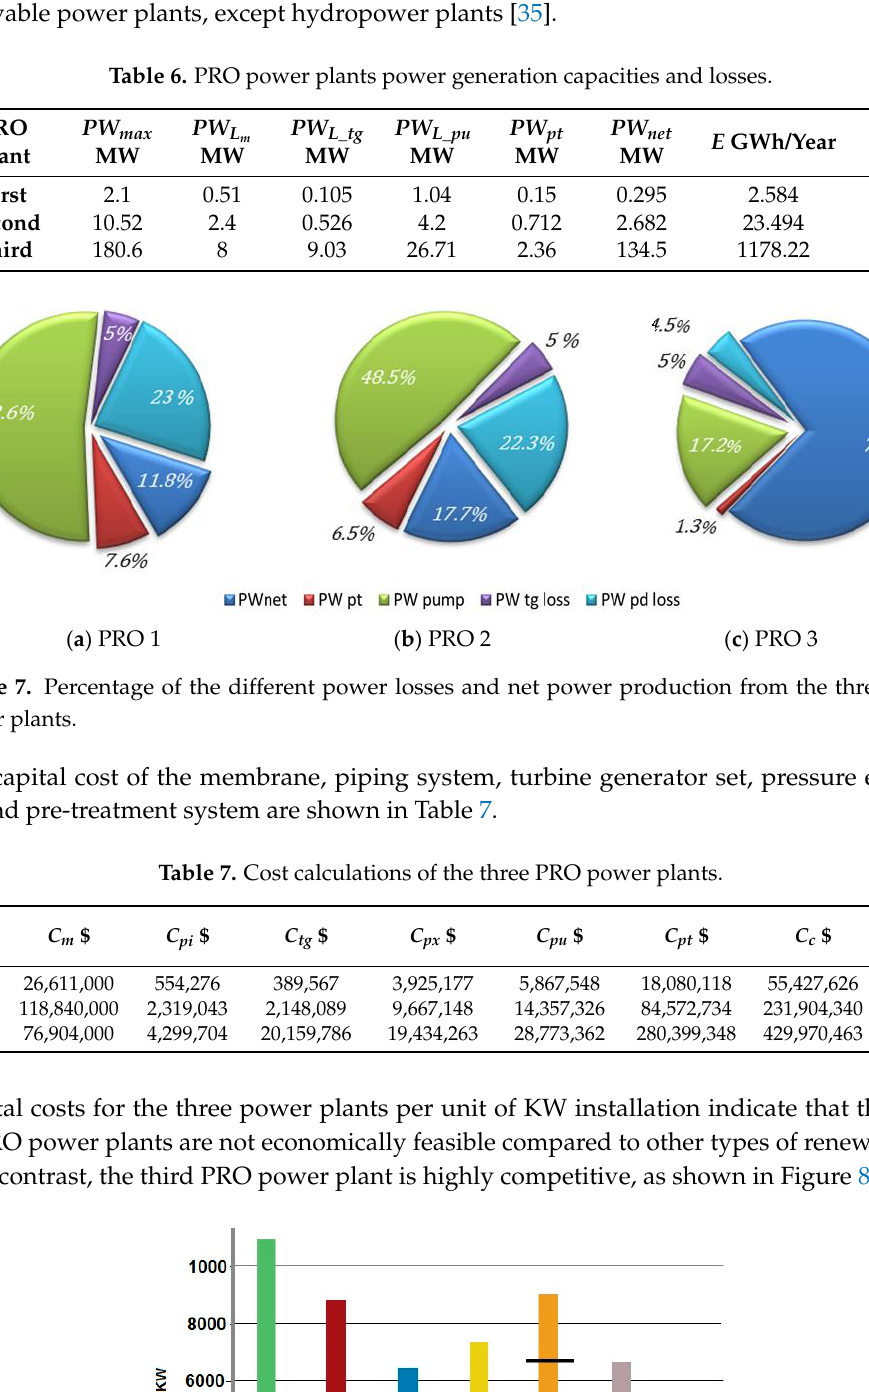
Table 6. PRO power plants power generation capacities and losses.